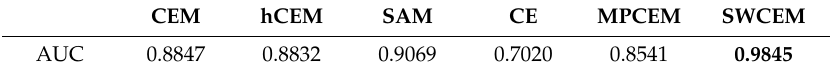
Table 5. The area surrounded by ROC curves of different algorithms on the AVIRIS Dataset 2.